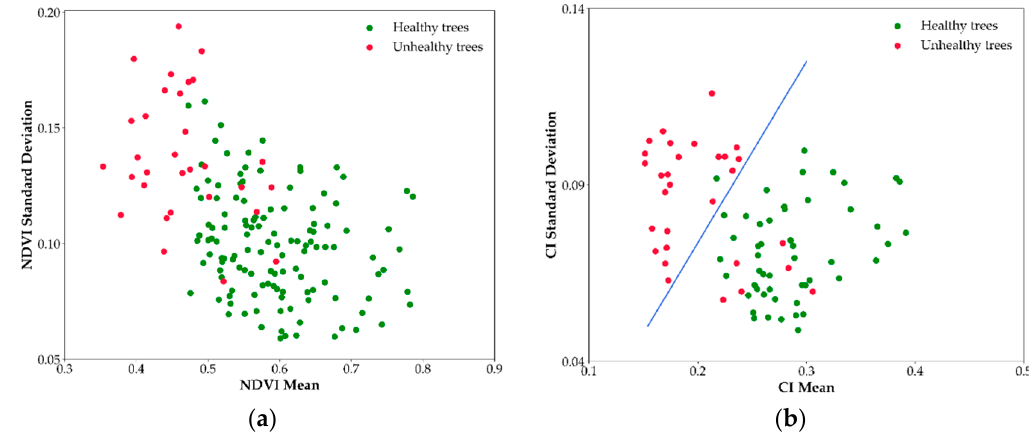
Figure 8. Relationship between NDVI ( a ) and CI ( b ) temporal mean and temporal standard deviation for the HMG test site (green circles correspond to healthy trees while red circles correspond to unhealthy trees).